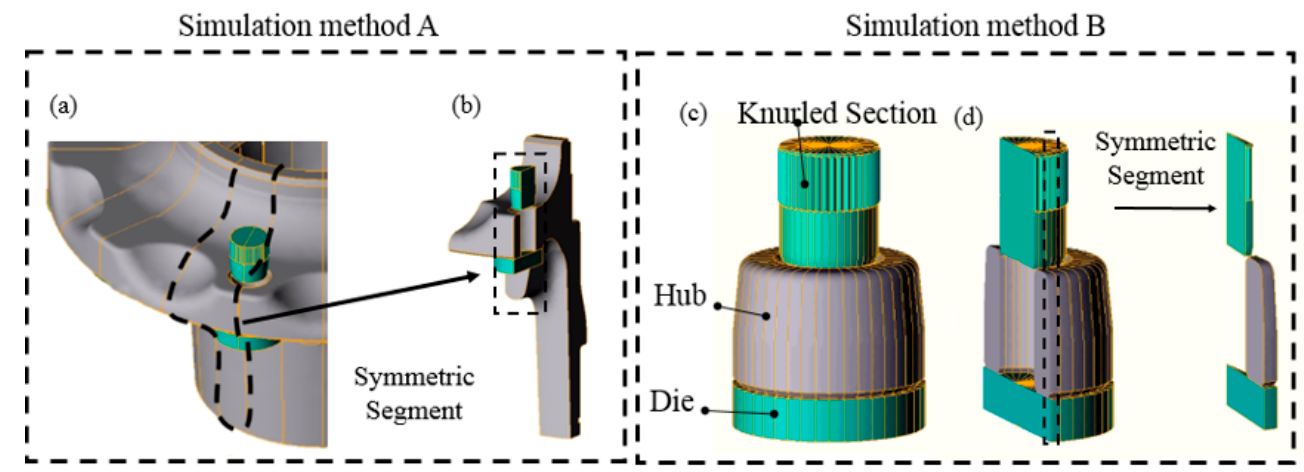
Figure 6. Design of simulation models: ( a ) one of knurled fit model, ( b ) symmetric segment of one knurled fit model, ( c ) one of a hoop of the hub, and ( d ) symmetric segment of a hoop.